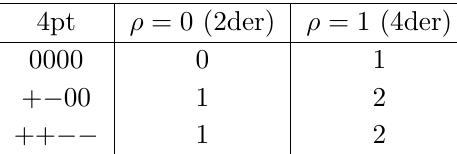
Table 1 . The number of independent monomials for pure scalar 4pt vertices with 2 derivatives ( ρ = 0 ) and 4 derivatives ( ρ = 1